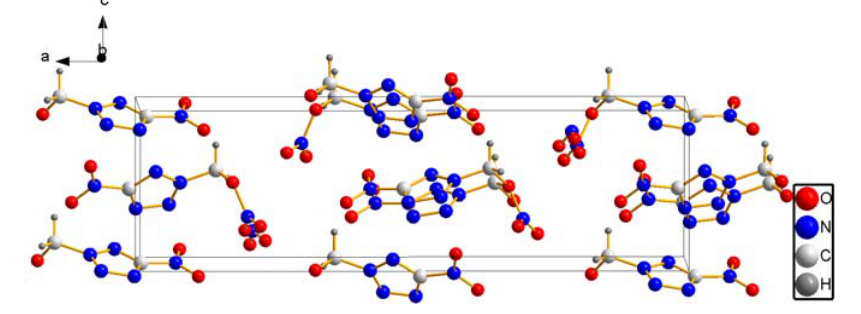
Figure 2. The packing diagram of compound 4